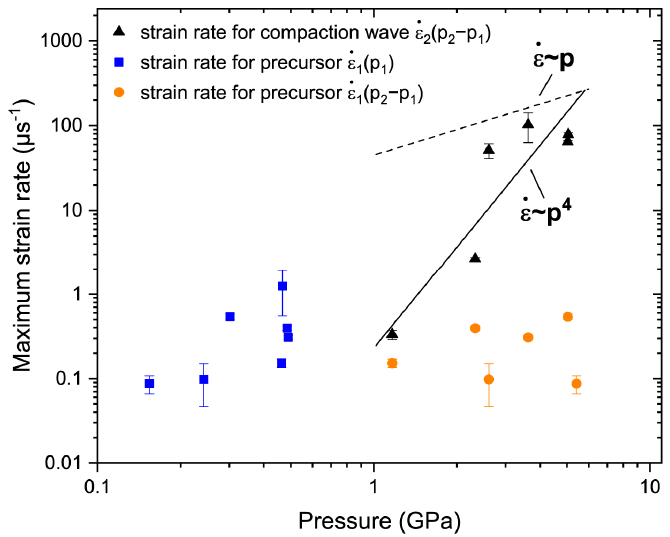
Figure 7. Strain rate versus pressure for the precursor and compaction waves. The strain rates for the precursor ε 1 and compaction wave ε 2 were obtained by Equations (2) and (4), respectively, only for experiments with 7- and 10- μ m thick reflective foils. p 2 − p 1 is the pressure rise only in the compaction wave, and p 1 and p 2 are the pressures behind the precursor and compaction wave fronts, respectively. The points ε 1 ( p 2 − p 1 ) are drawn only for experiments where the parameters for the compaction wave are available; such representation illustrates how ε 1 depends on the applied pressure.